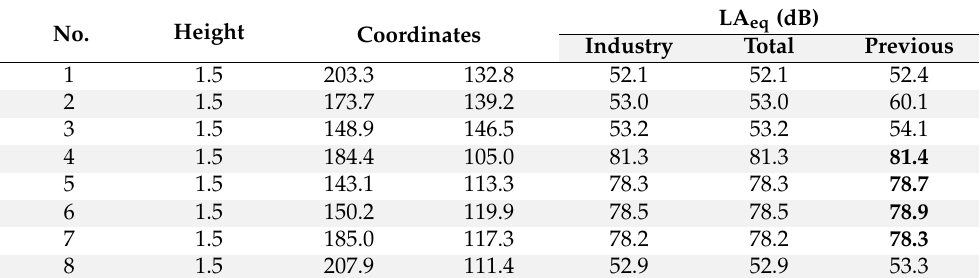
Table 5. Table of calculated values of measured points for demolition work, with the separate deploy- ment of machines.